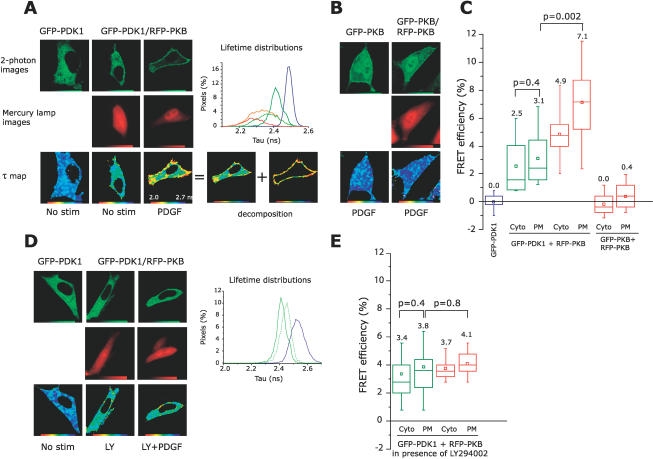
PDK1 Interacts with PKB in a Phosphatidylinositol 3-Kinase–Dependent Manner at the Membrane and in a Phosphoinositide-Independent Manner in the Cytoplasm(A) NIH3T3 cells were transfected with GFP-PDK1 alone or with RFP-PKB. The lifetimes are presented in pseudo-colour scale ranging from 2.0 to 2.7 ns. The graph presents the lifetime distributions of the cells for the following conditions: GFP-PDK1 (blue), GFP-PDK1 with RFP-PKB prior (green) and upon PDGF stimulation (orange). The red and the light green lines indicate the lifetime distributions of the plasma membrane and cytoplasm pixels, respectively, after separation of the compartmental pixels (see decomposition).(B) NIH3T3 cells were transfected either with GFP-PKB alone or together with RFP-PKB. The FRET efficiency variation is statistically insignificant.(C) The statistical analysis of experiments in A and B are presented as box and whiskers plots (see Supporting Information). The FRET efficiency was calculated for at least ten cells per condition for the cytoplasmic (Cyto) and plasma membrane (PM) components, as indicated. The first column shows the variation of the donor lifetime (blue) centred at zero. The dispersion is less than ±1%. The FRET efficiency of GFP-PDK1 + RFP-PKB condition is presented before (green boxes) and after (red boxes) PDGF stimulation. The FRET efficiency of the control GFP-PKB + RFP-PKB upon PDGF is presented by the two last boxes. The mean value of the FRET efficiency is indicated on top of each box. The highly significant FRET efficiency variations at (PM), for experiment A, is indicated by a p-value of 0.002 (see Supporting Information).(D) Similar experiment as in (A) was performed but cells were first pretreated for 20 min with LY294002. The graph shows the superposition of the lifetime distributions of coexpressed GFP-PDK1 and RFP-PKB pretreated with LY294002 alone (green line) or pretreated with LY294002 before PDGF stimulation (dashed green line). Control GFP-PDK1 lifetime distribution is shown in blue.(E) The FRET efficiency between LY294002- and LY294002 + PDGF–treated cells do not vary significantly (p = 0.8).